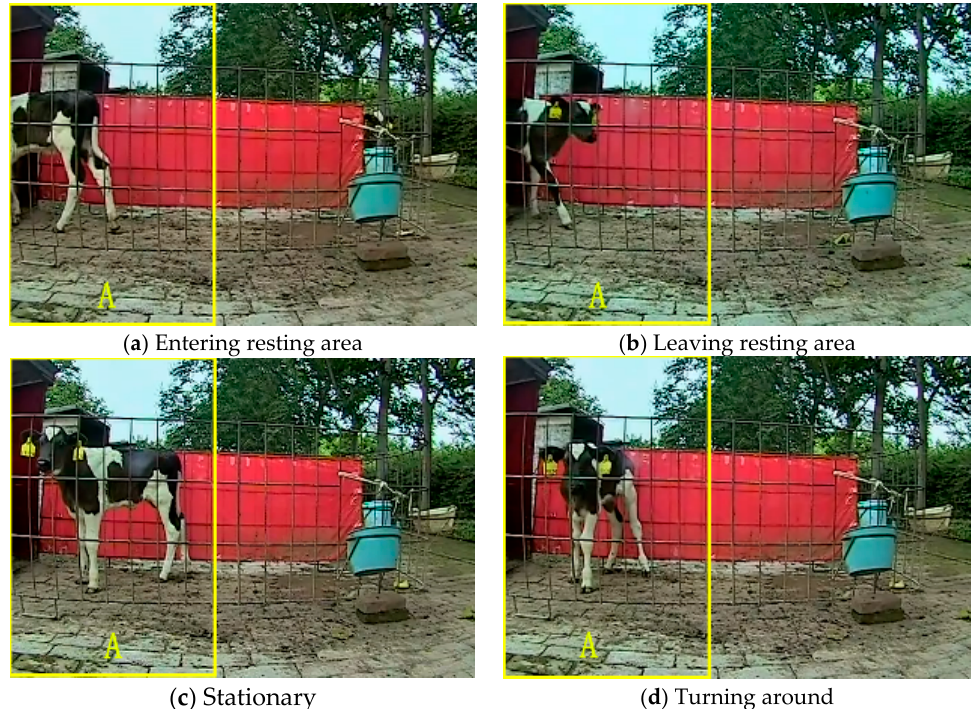
Figure 6. Example behaviors in Area A: ( a ) the calf is entering the resting area; ( b ) the calf is leaving the resting area; ( c ) calf is stationary; and ( d ) calf is turning around.